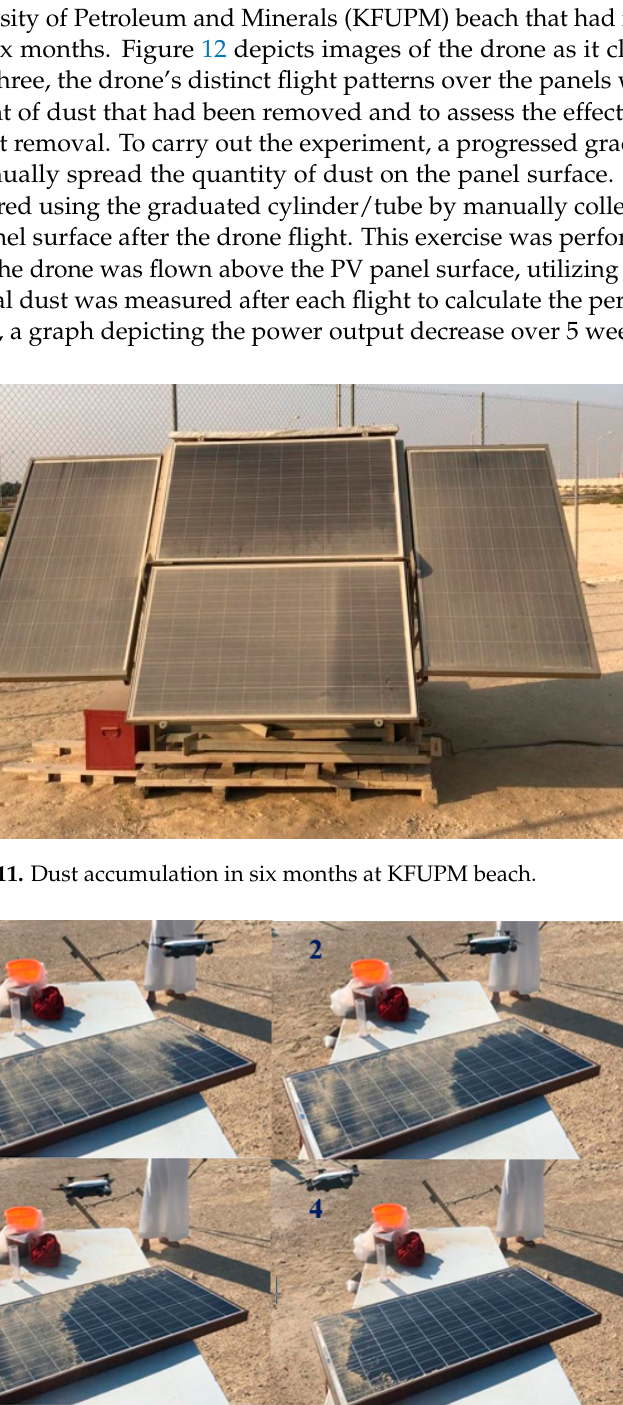
Figure 12. The sequence of the drone’s cleaning process.